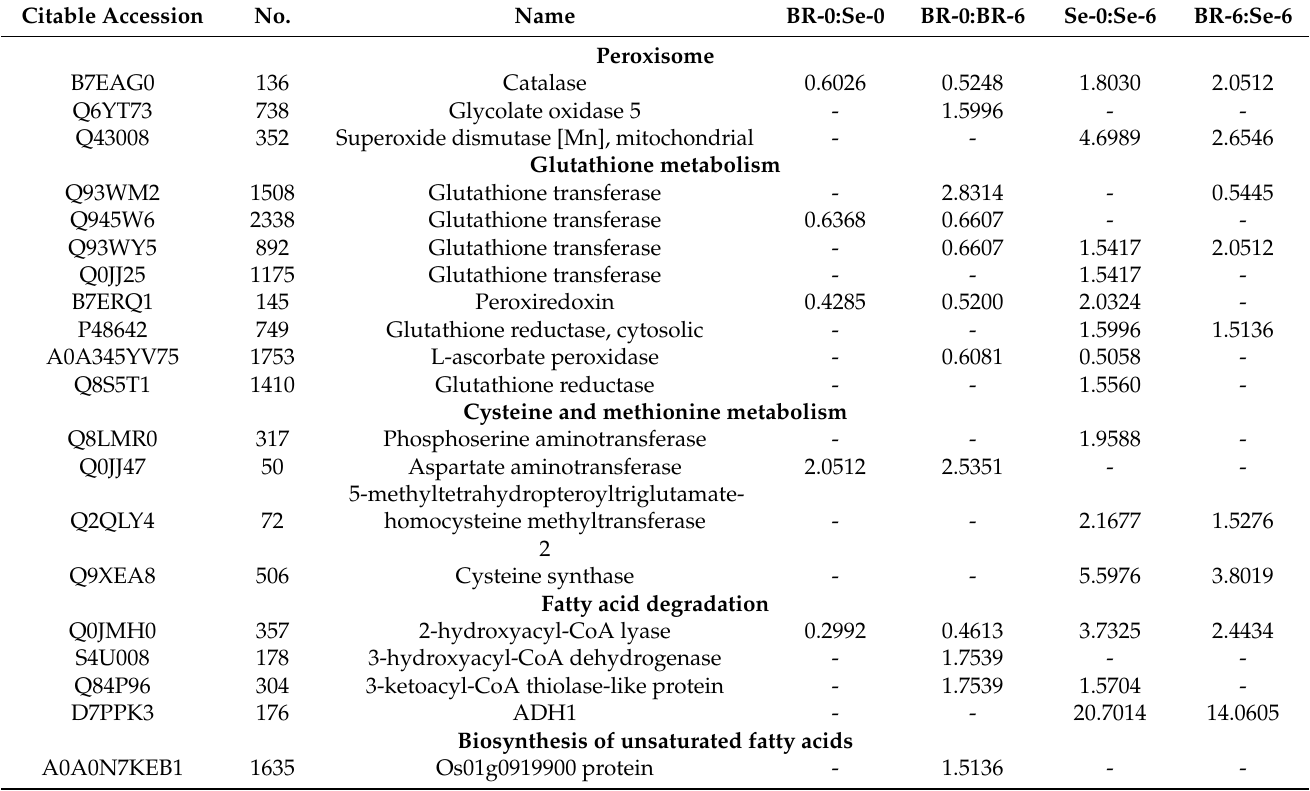
Table 3. Expression of DEPs by different metabolic